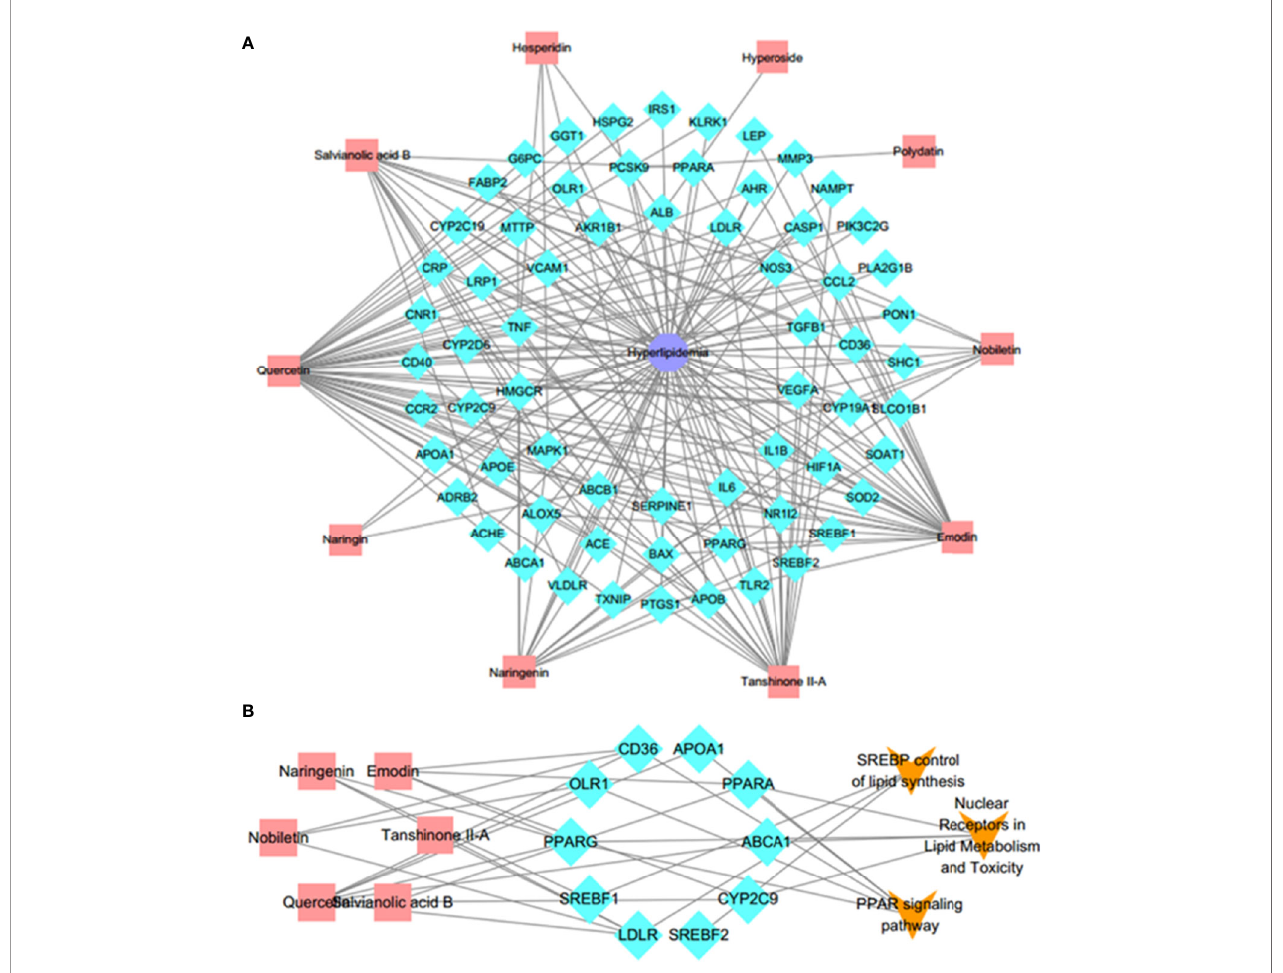
FIGURE 4 | C – T – D network and C – T – P network. (A) Active C – T – D network of 10 compounds and 65 common potential targets in treatment of hyperlipemia. The aquamarine rhombus nodes represent the targets, red rectangle nodes delineate the compounds, and indigo octagon nodes delineate the disease. (B) C – T – P network. The C – T – P network was constructed by linking compounds, targets, and their related pathways. The nodes represent compounds (red rectangle), targets (aquamarine rhombus), and pathways (orange v-shaped). C – T – D, compounds – potential targets – disease; C – T – P, compounds – targets – pathways.